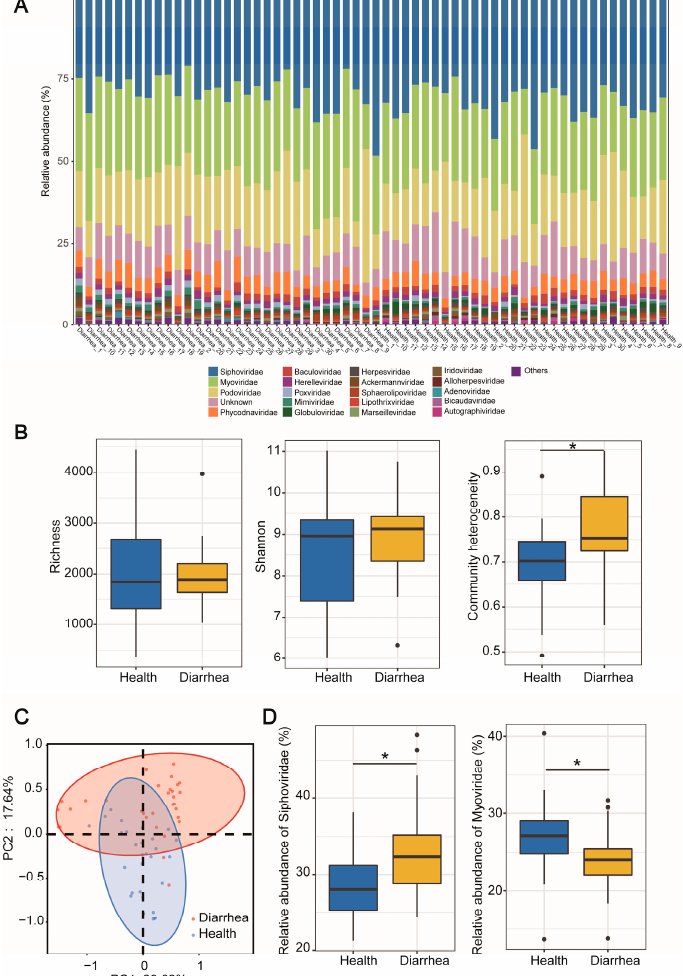
Figure 1. Composition, diversity and structure of gut virome in healthy and diarrheal piglets. ( A ) The relative abundance of the top 20 viral families. ( B ) Alpha diversity and community heterogeneity in healthy and diarrheal neonatal piglets. ( C ) PCOA metrics of viral community based on Bray–Curtis distance. ( D ) Relative abundance of differential viral families in healthy and diarrheal neonatal piglets. * p < 0.05. n = 30.